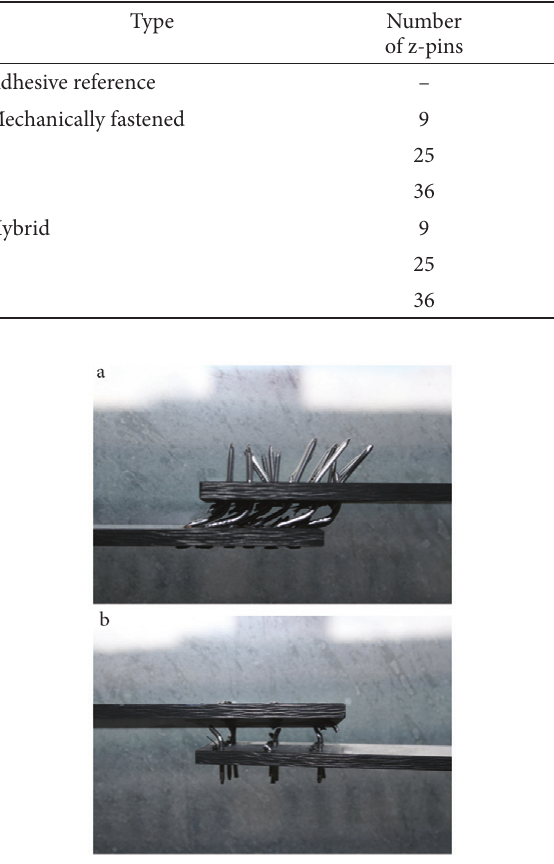
Fig. 7. Failure character: a – the hybrid joint with 36 pins; b – the mechanically fastened counterpart with 9 pins